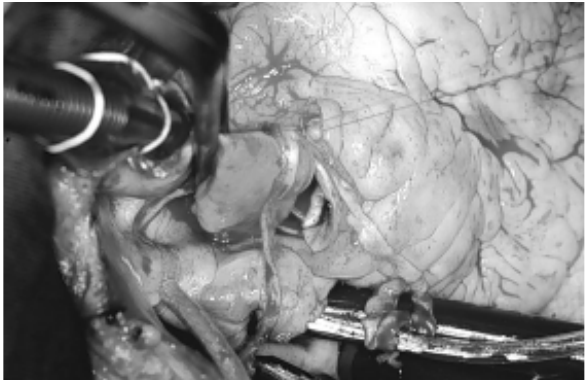
Fig. 1 - Reforço da sutura da aortotomia com duas tiras de pericárdio